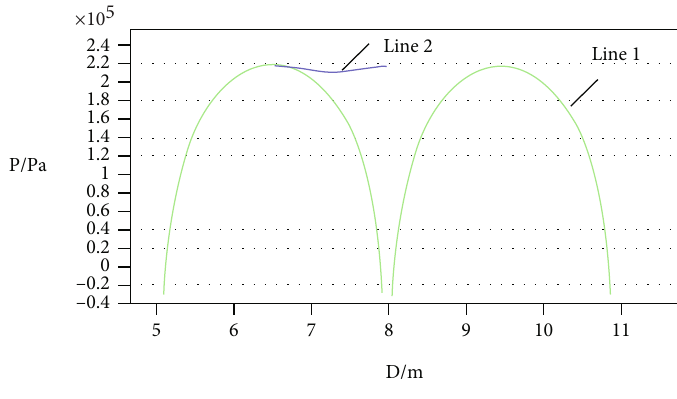
Figure 10: The value line